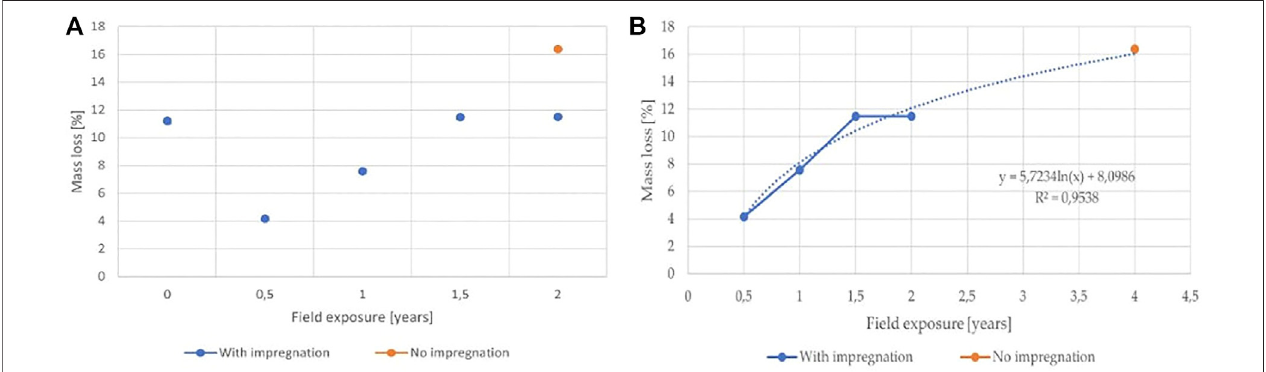
FIGURE 5 | (A) Mass loss over fi eld exposure (all samples); (B) Prediction of the development of mass loss in samples over 2 years of age.